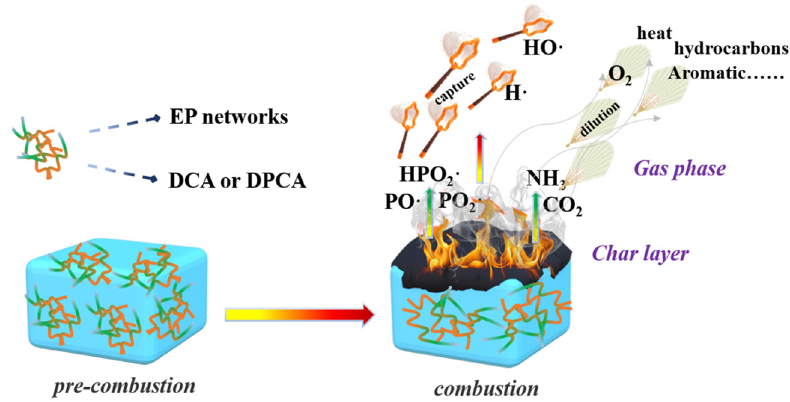
Figure 10: The possible FR mechanism of EP – DPCA and EP – DCA.